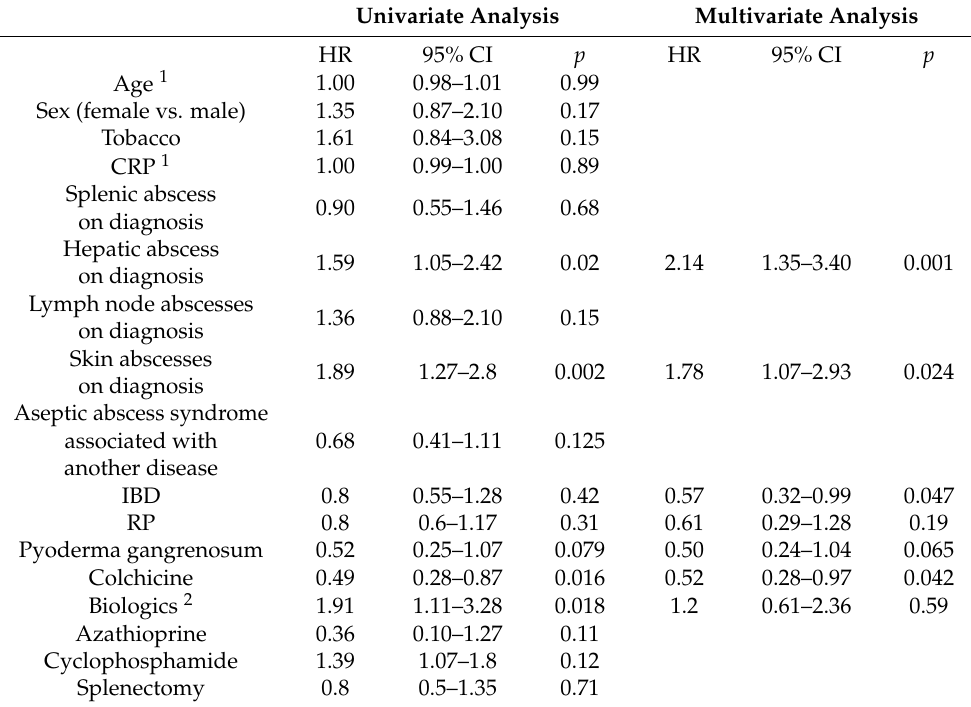
Table 4. Risk factors for aseptic abscess syndrome relapse in 71